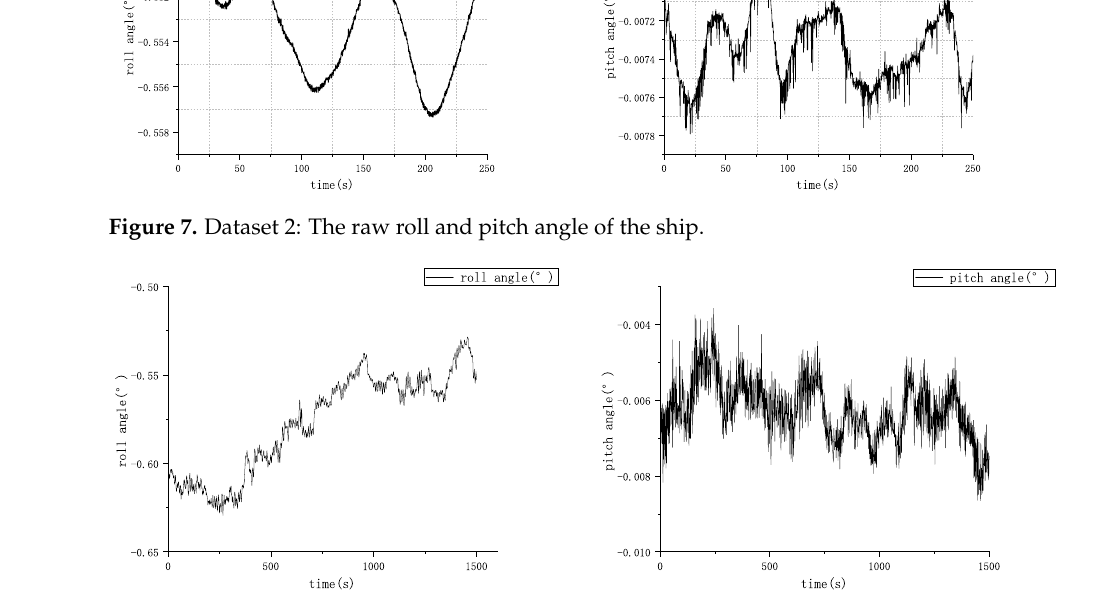
Figure 8. Dataset 3: The raw roll and pitch angle of the ship.